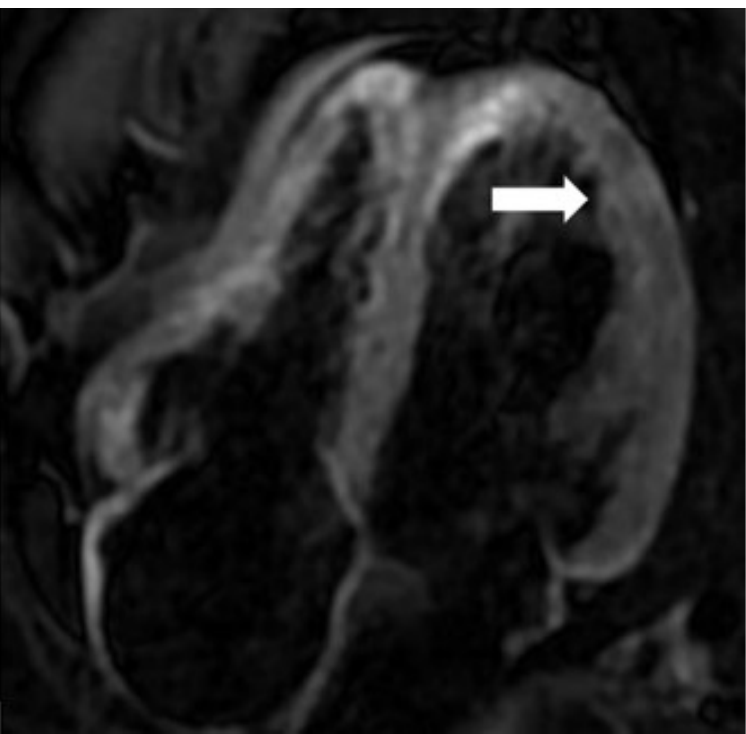
Figure 1. CMR imaging demonstrates epicardial type of late gadolinium enhancement involving the mid-inferoseptal and mid-anterolateral segments (Arrow) ( A ), the midwall type of LGE involving the basal-inferolateral segments (Arrow) ( B ), and multiple patchy type LGE involving the antero- lateral, lateral, with inferior septal midwall (Arrow) ( C ).